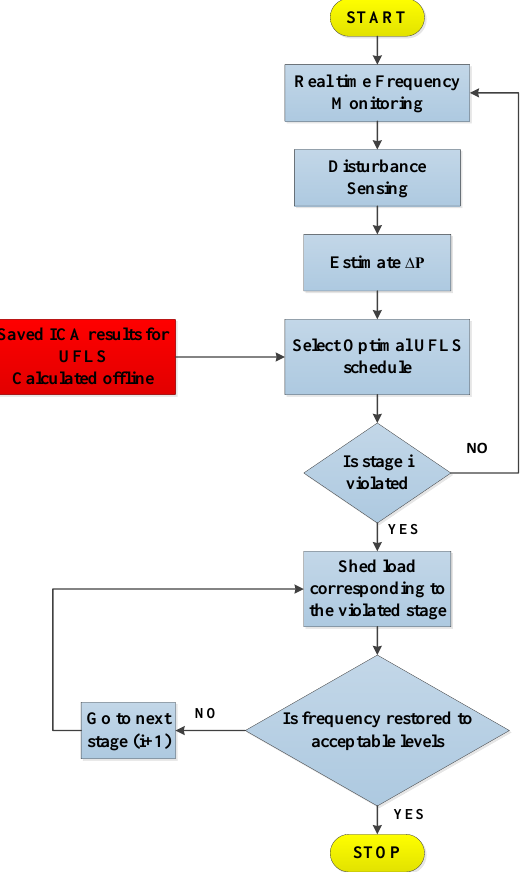
Figure 3. Flowchart of the online implementation of the proposed WAMS-based optimal multi-stage UFLS